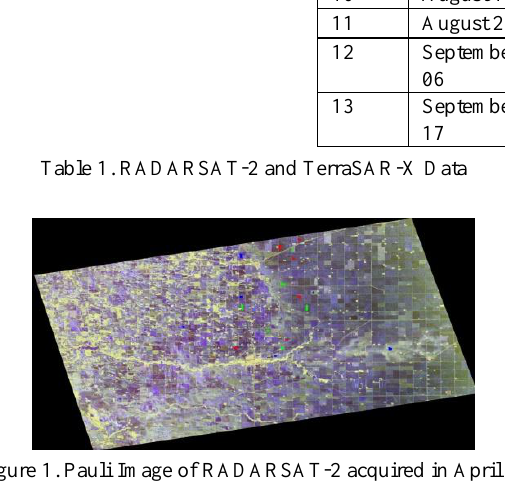
Figure 3. A speckle reduced images using Gaussian BoxCar filter for polarimetric TerraSAR-X HH polarization, window site 5x5